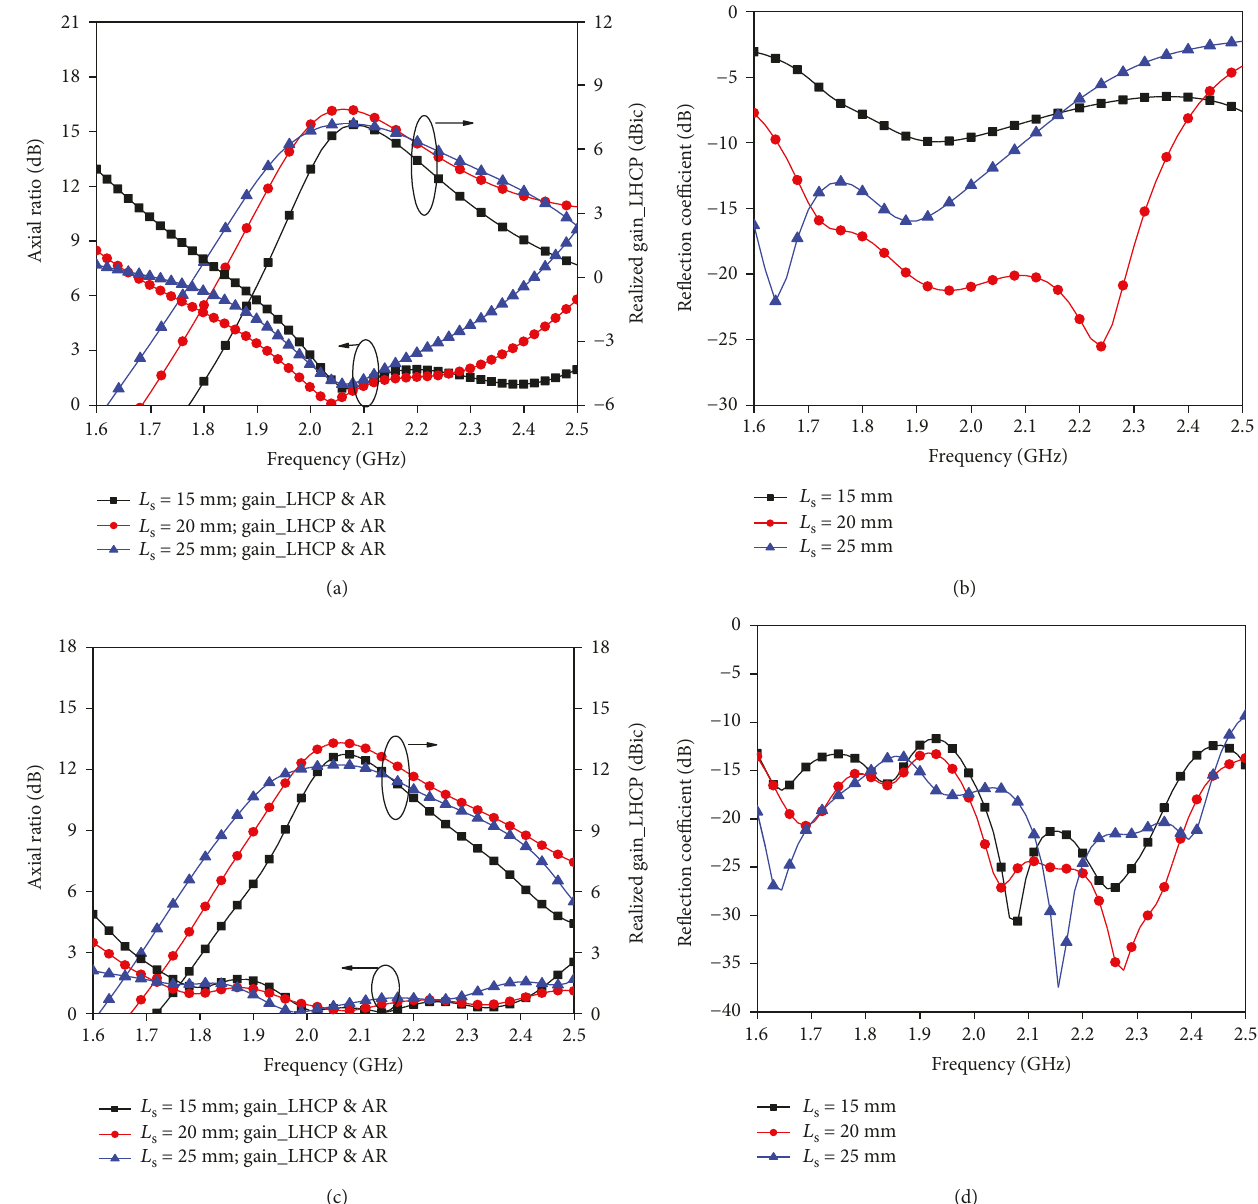
Figure 5: E ff ects of the length of the U-slot ’ s horizontal arm. (a) Realized gain and axial ratio of the element. (b) Re fl ection coe ffi cient of the element. (c) Realized gain and axial ratio of the array. (d) Re fl ection coe ffi cient of the